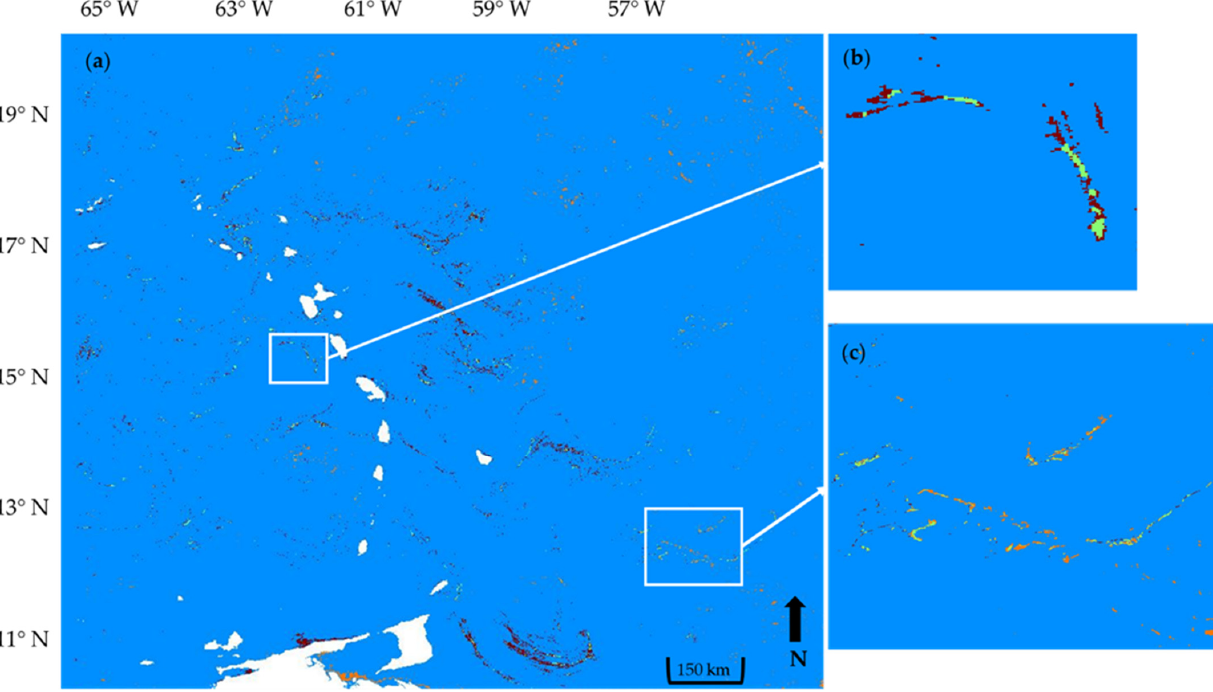
Figure 8. Sargassum identification using the two approaches proposed in this study (i.e., reflectance thresholding approach and δ MCI thresholding approach) for the 8 July 2017 13:00 scene: ( a ) for the OLCI entire scene, ( b ) for a sub-area located westward of the Dominica Island and ( c ) for a sub-area located in the southeast of the scene. The results for each approach are presented using a different color: red color is used for the reflectance thresholding method and orange color is used for the δ MCI thresholding approach. If both approaches agree, pixels are colored in green. Land pixels are colored in white while Sargassum -free pixels (i.e., water only) are colored in blue. Clouds are also colored in blue to enhance the visibility of Sargassum areas.